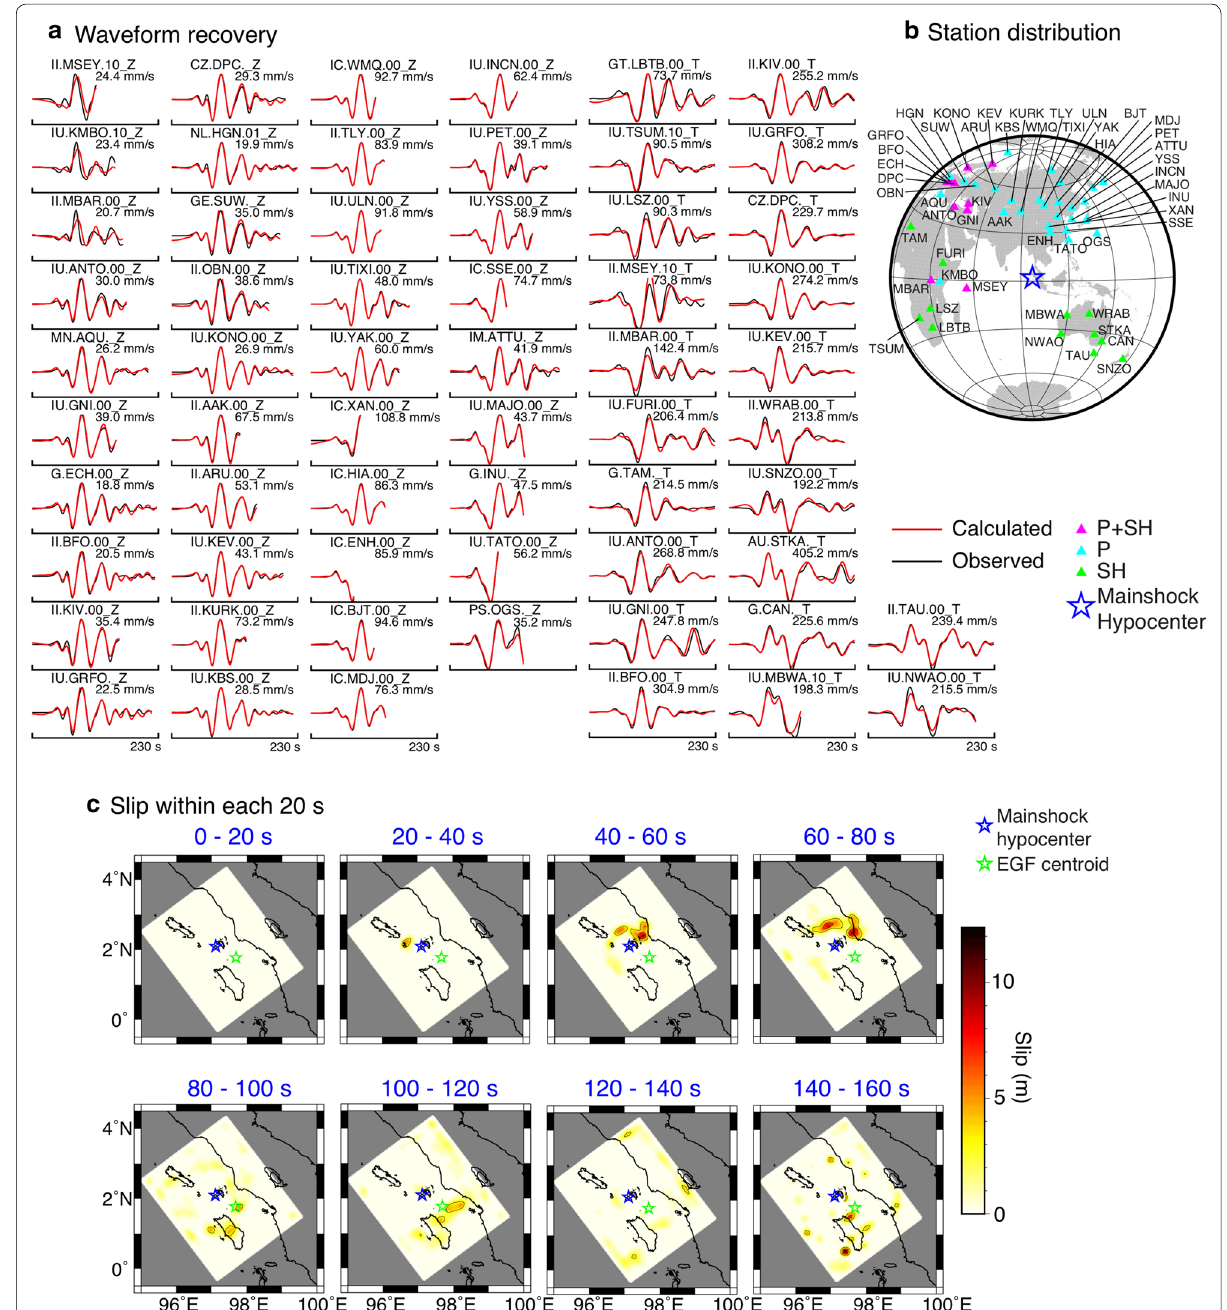
Fig. 4 Slip inversion for the Nias Earthquake using EGF4. As in Fig. 2, but for the Nias Earthquake determined using EGF4 (16 Apr 2005, M W 6.4